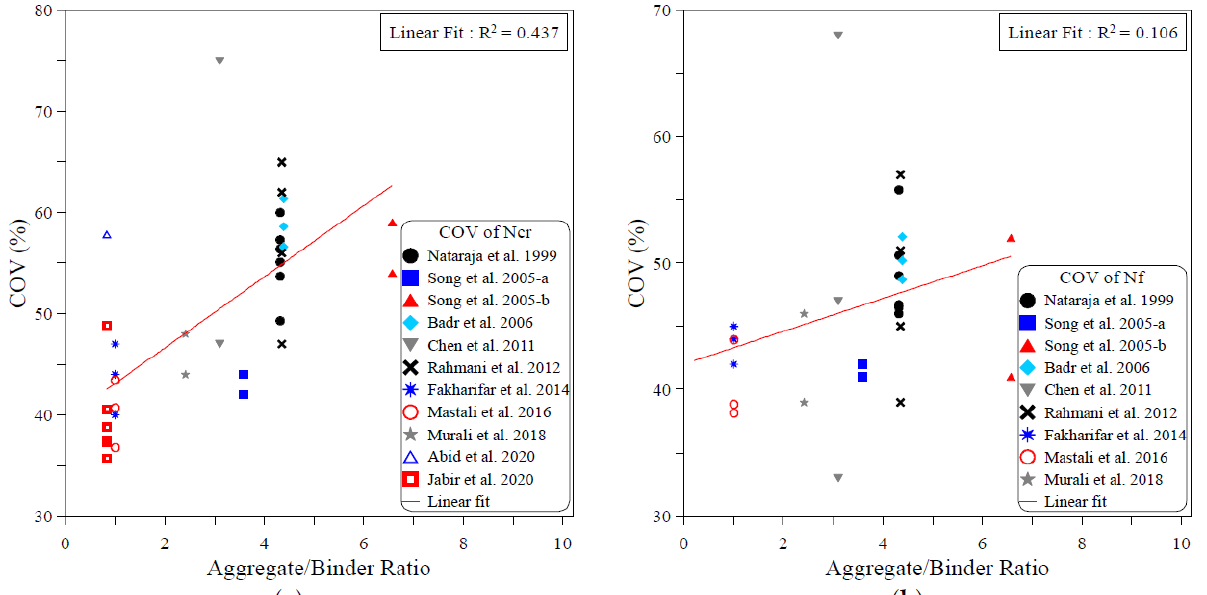
Figure 2. Effect of binder content on the scattering of impact results at ( a ) cracking and ( b ) failure.